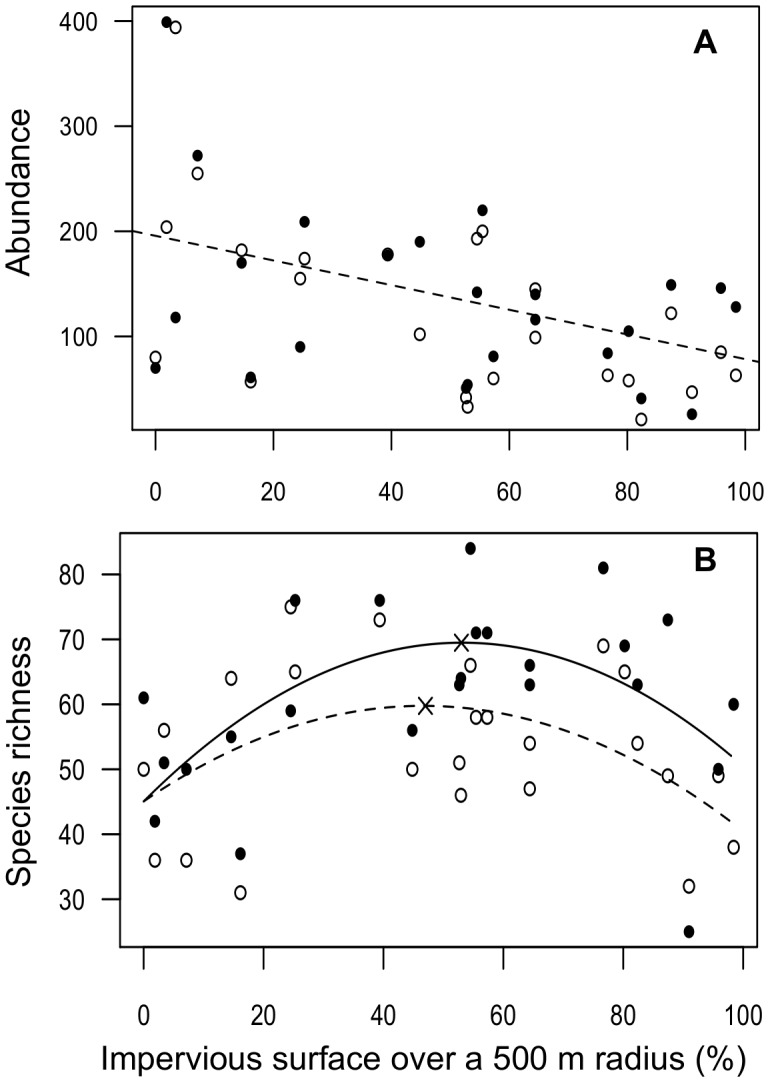
Effect of impervious surface percentage within 500 m on the abundance and species richness of bees.A. Abundance of bees (filled circles = 2011, open circles = 2012); B. Species richness of bees (filled circles and full line = 2011, open circles and dashed line = 2012). Model for species richness  =  Impervious
surface (Year) + Impervious
surface
2 (Year).